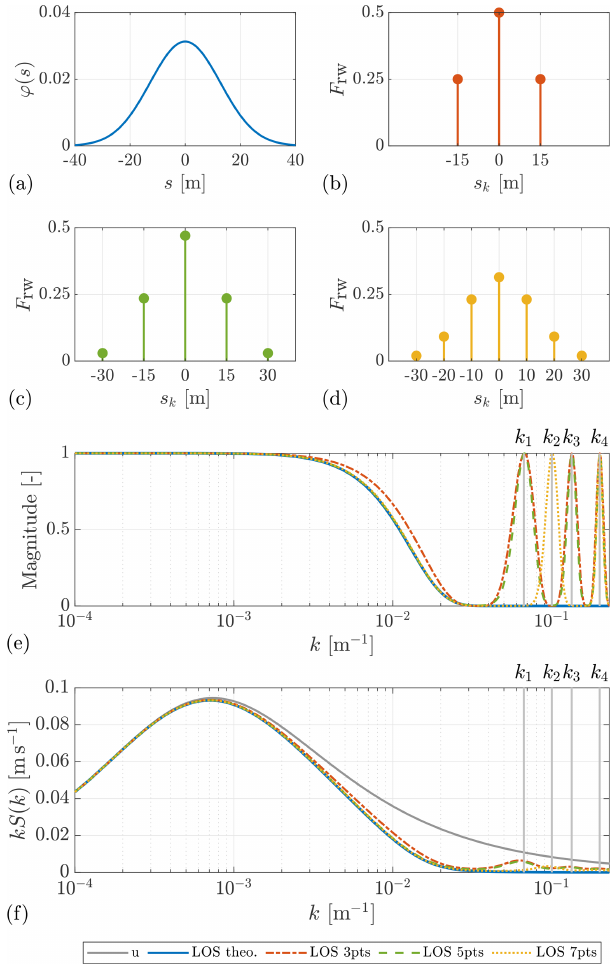
Figure 7. (a) Theoretical Gaussian-shape range weighting func- tion with a full width at half maximum of 30m for a pulsed li- dar. (b–d) Three-point, five-point, and seven-point normalized dis- crete approximations of the range weighting function, with steps (cid:49)s k of 15, 15, and 10m, respectively. (e) Magnitudes of the FFTs of the different discretizations of the range weighting func- tion. Critical wavenumbers: k 1 = 1 / 15m − 1 , k 2 = 1 / 10m − 1 , k 3 = 2 / 15m − 1 , and k 4 = 1 / 5m − 1 . (f) Theoretical auto-spectra of the u component and the LOS measurements of the different discretiza- tions of the range weighting function. The LOS measurements are assumed aligned to the wind